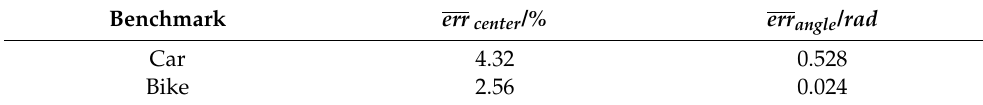
Figure 28. The 3D localization results of the cars and bikes in the outdoor test scene. Table 11. Localization error statistics in the outdoor test scene.